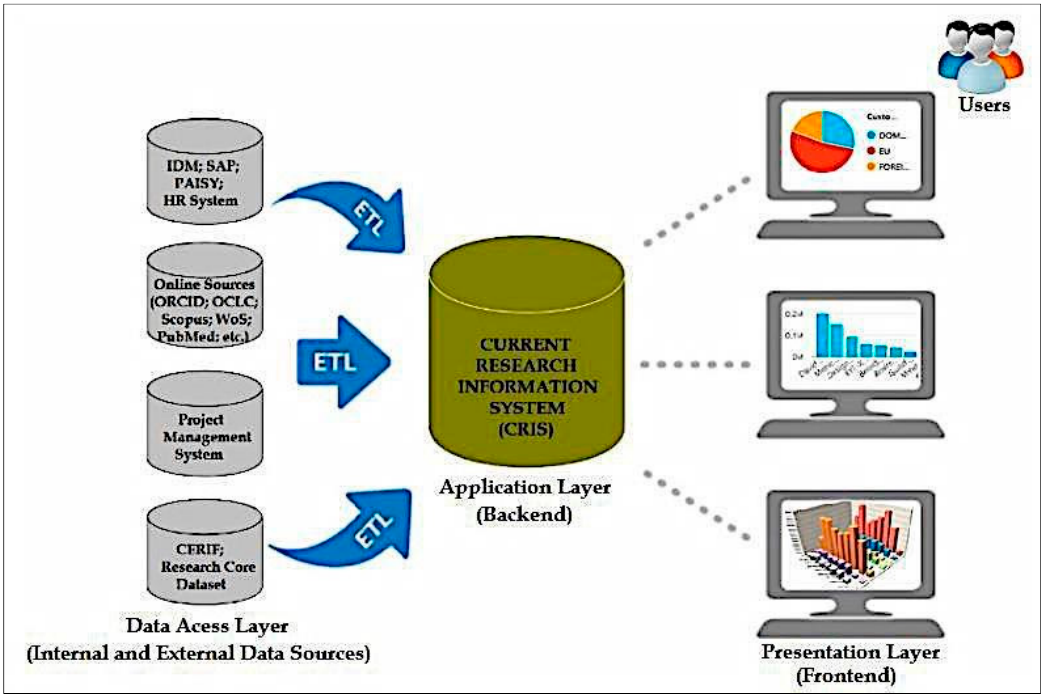
Figure 1. Architecture of CRIS.